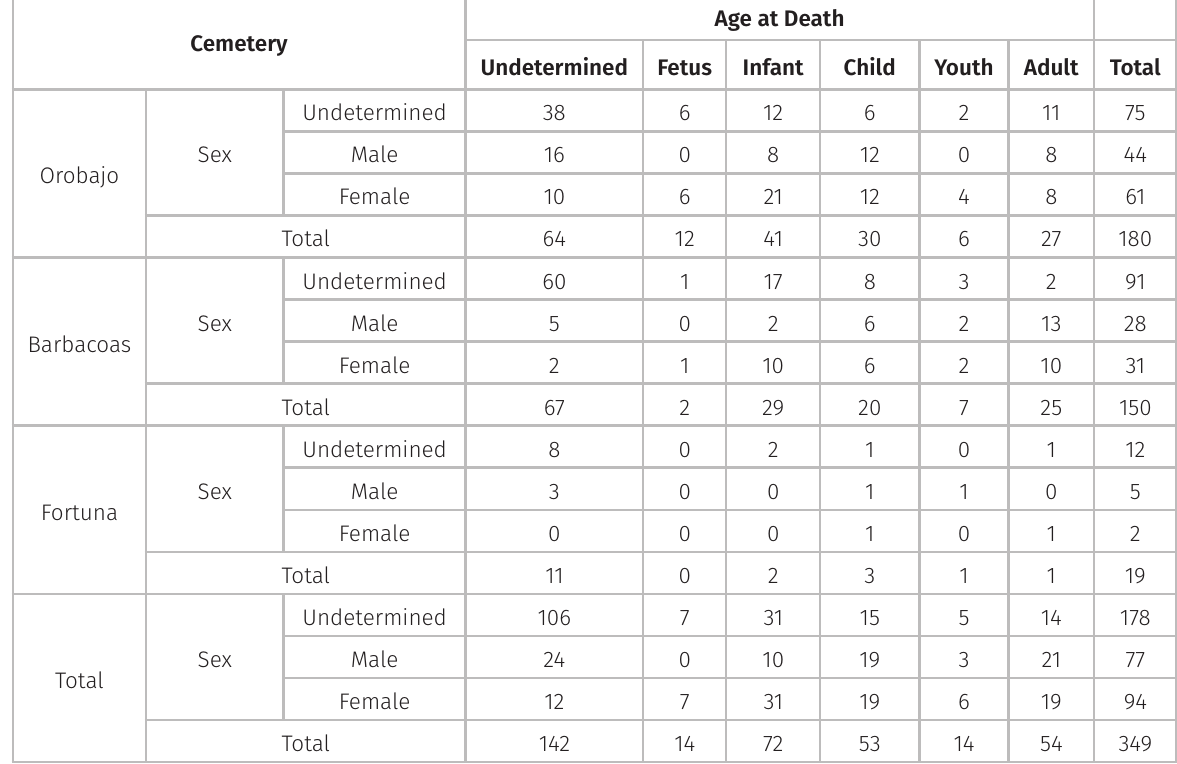
Table VI. Consolidated sex and age at death data of bodies exhumed in cemeteries.